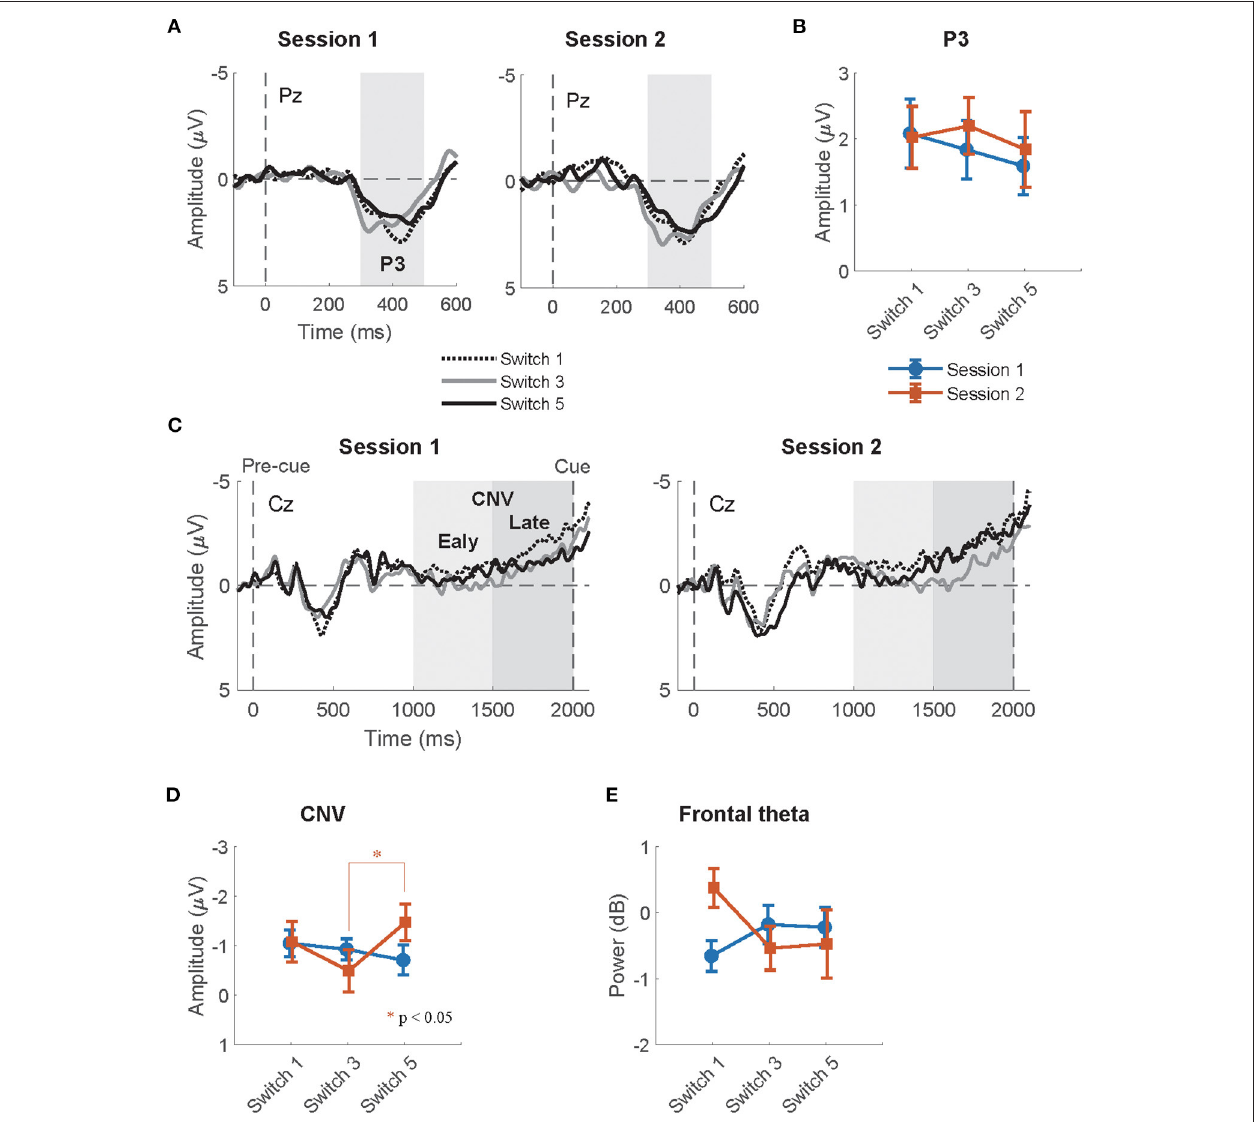
FIGURE 4 | (A) The grand-average ERP relative to pre-cue onsets at Pz per session and switch type. The highlighted time window was used for the calculation of the mean amplitudes of P3. (B) The mean amplitude of the P3 relative to pre-cue onsets at Pz per session and switch type. (C) The grand-average CNV